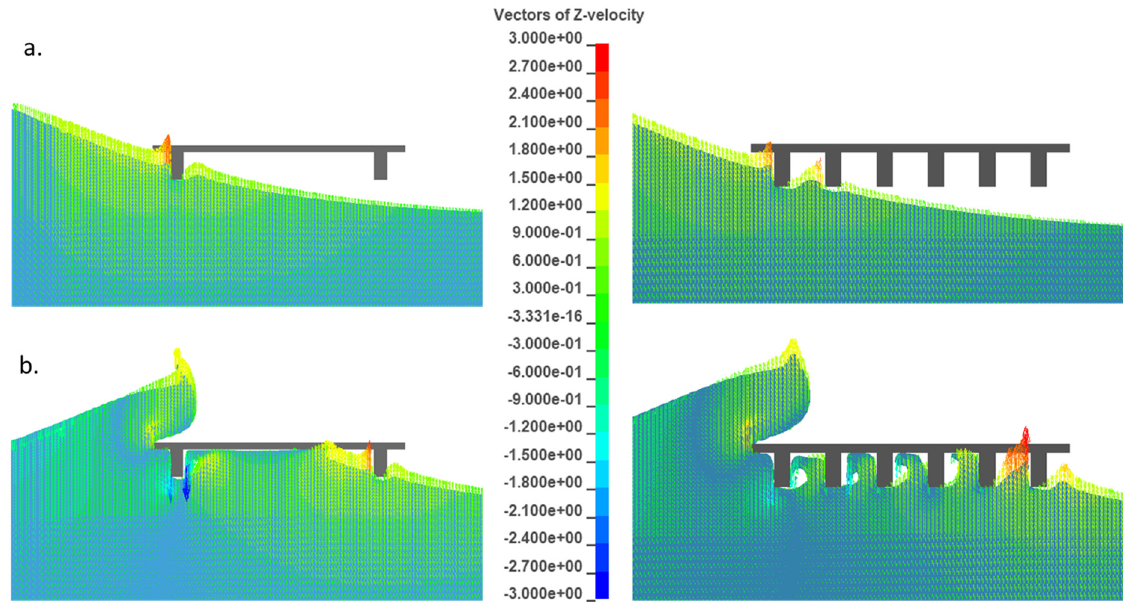
Figure 16. Snapshots of the vectors of the vertical fluid velocities of wave SW3.6 ( H = 0.85 m) impacting a deck with two girders ( left ) and six girders ( right ) at two instants: ( a ) t = 6.2 s and ( b ) t = 6.5 s.